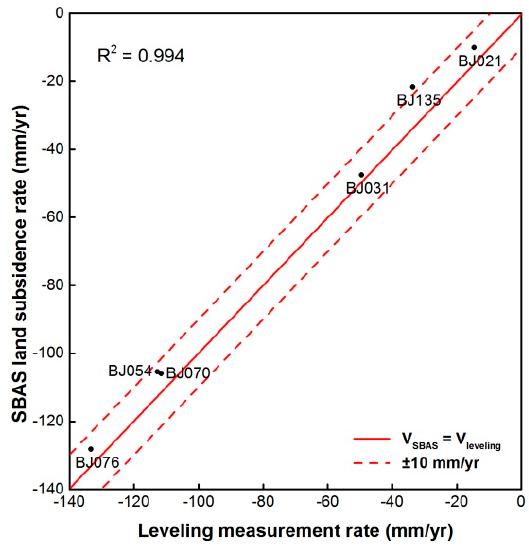
Figure 4. Comparisons of SBAS-derived land subsidence rates and leveling measurement rates from 2011 to 2013.The location of benchmarks is marked as “BJ021”, “BJ031”, “BJ054”, “BJ070”, “BJ076” and “BJ135” in Figure 1.